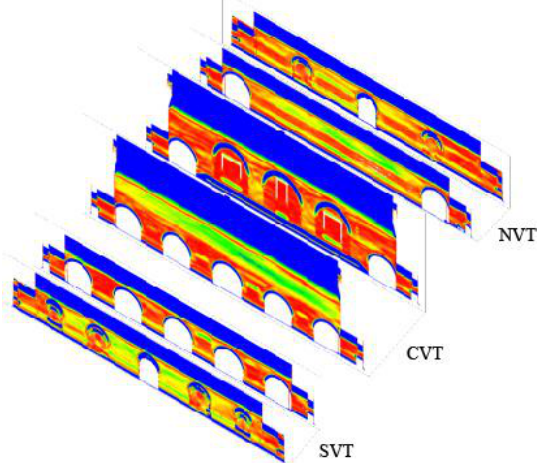
Figure 6. The longitudinal walls under vaults SVT, CVT, and NVT chromatically scaled according to computed geometric feature (verticality, radius=0.5m).